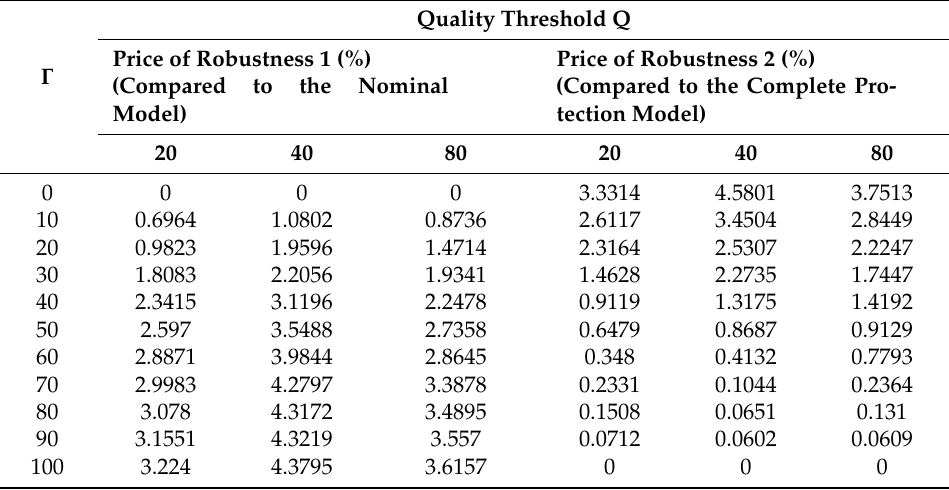
Table 1. The price of robustness for various quality